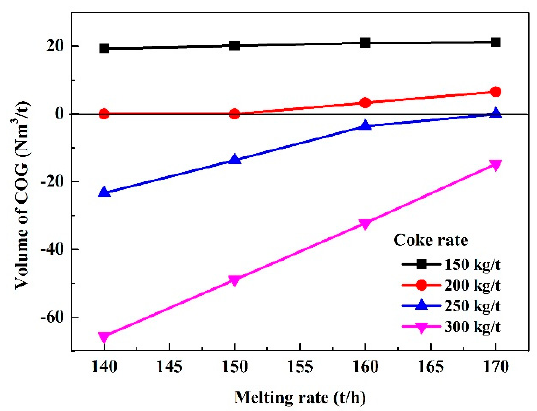
Figure 6. The volume of coke oven gas (COG) injection from dome for adjusting dome temperature.